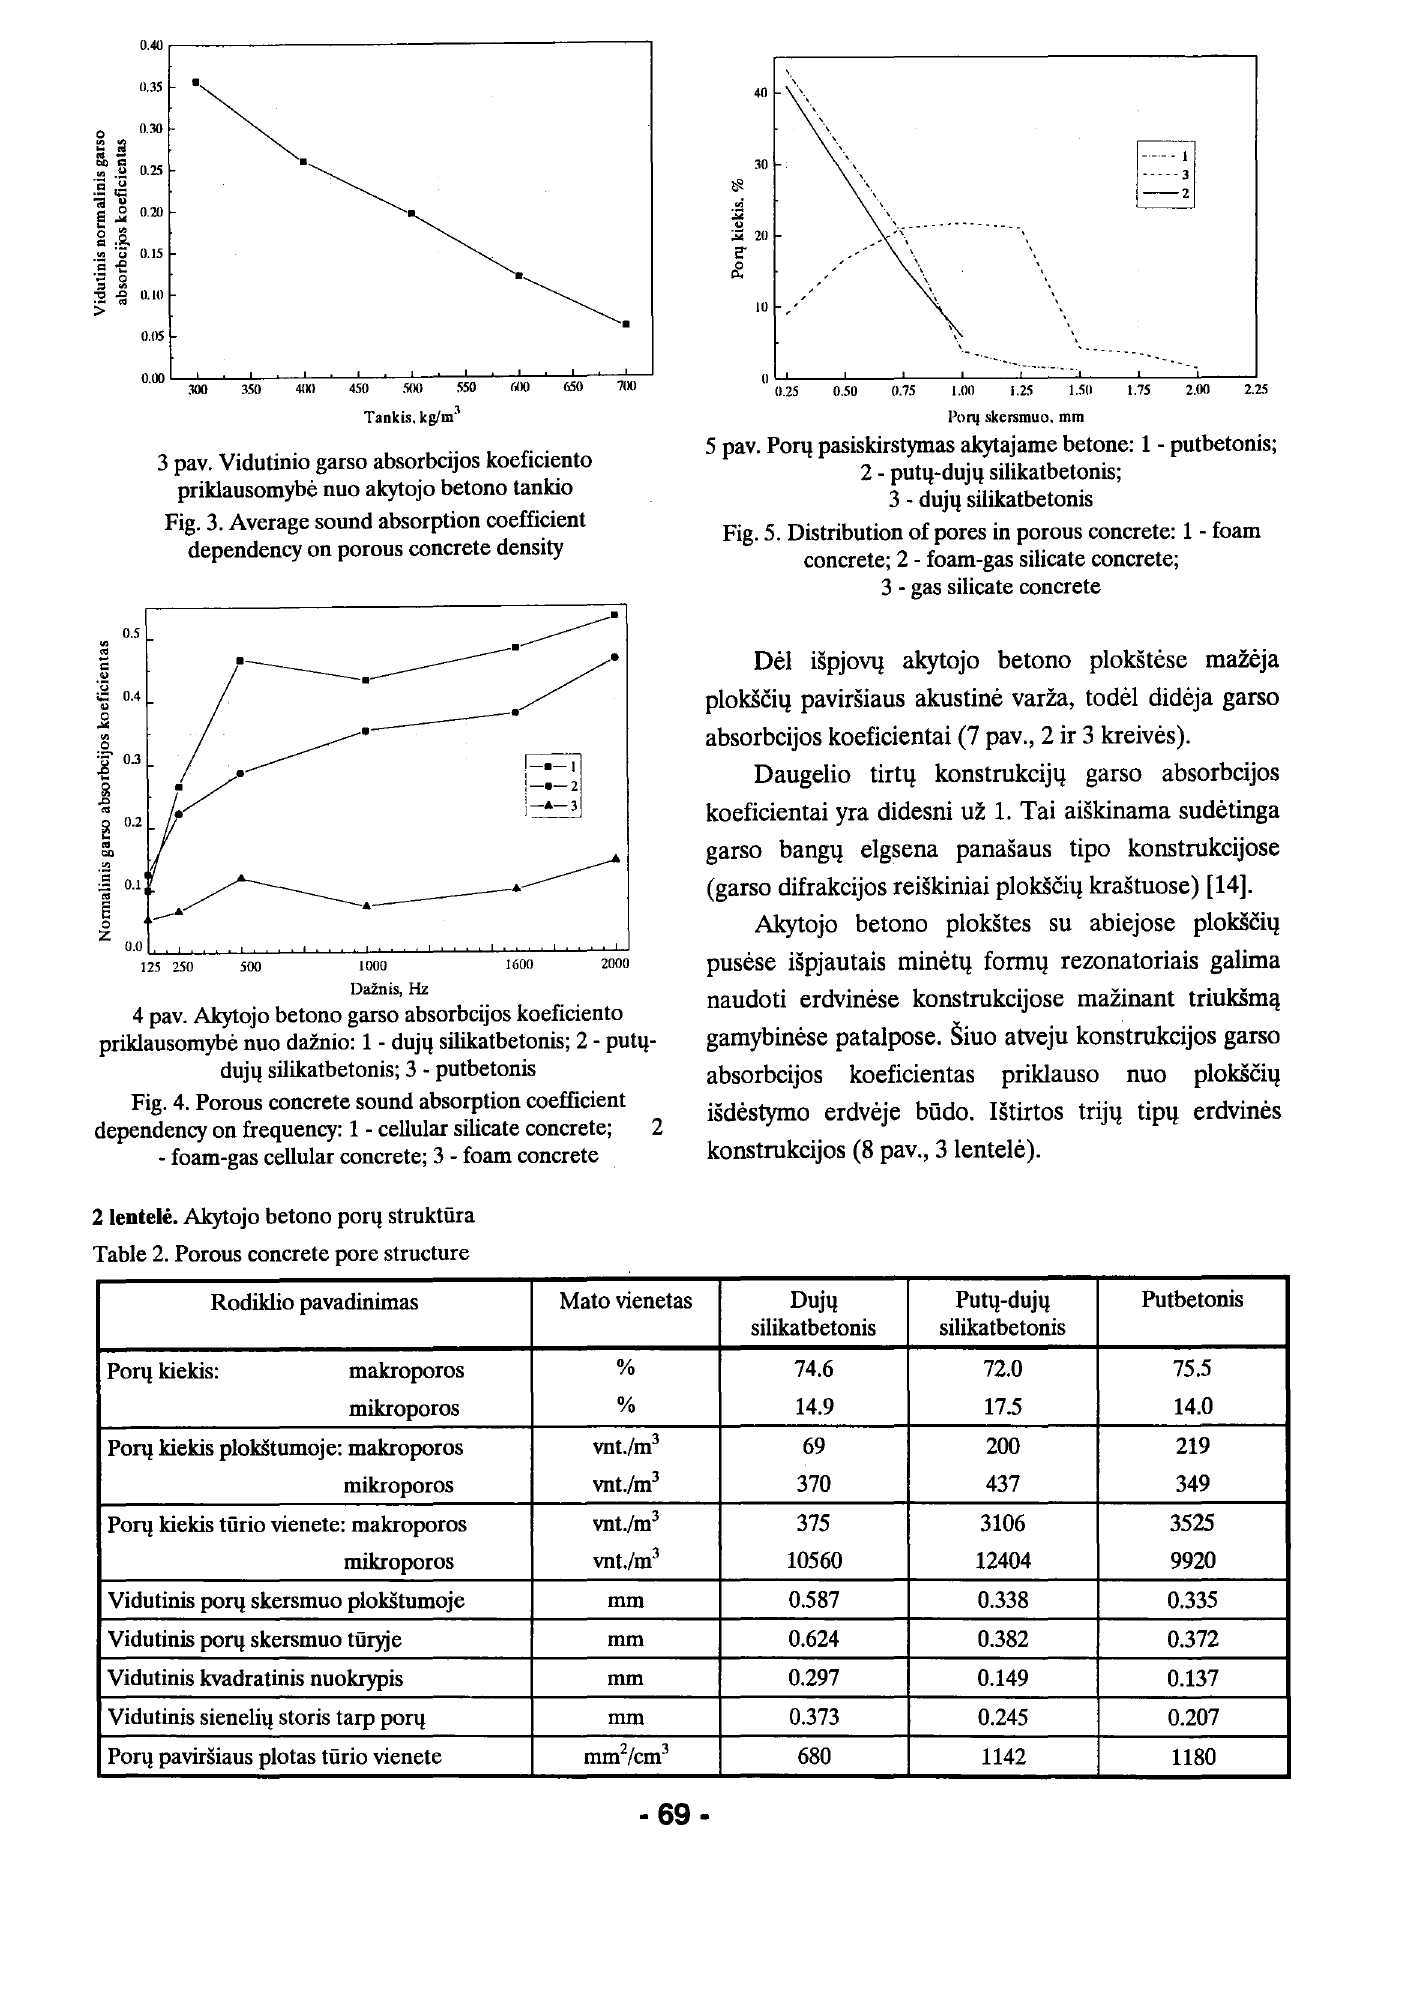
Fig. 3. Average sound absorption coefficient dependency on porous concrete density